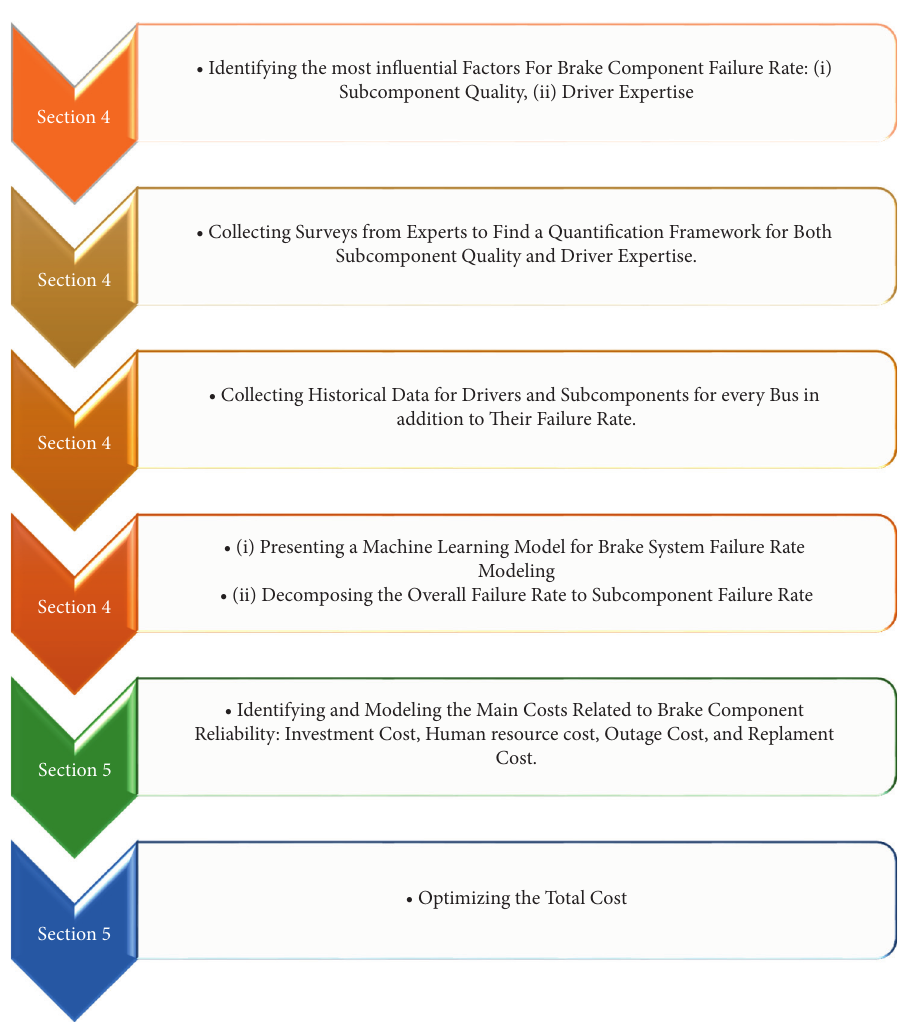
Figure 1: The general structure of the brake reliability-related cost minimization approach. Table 1: Score table for education and years of